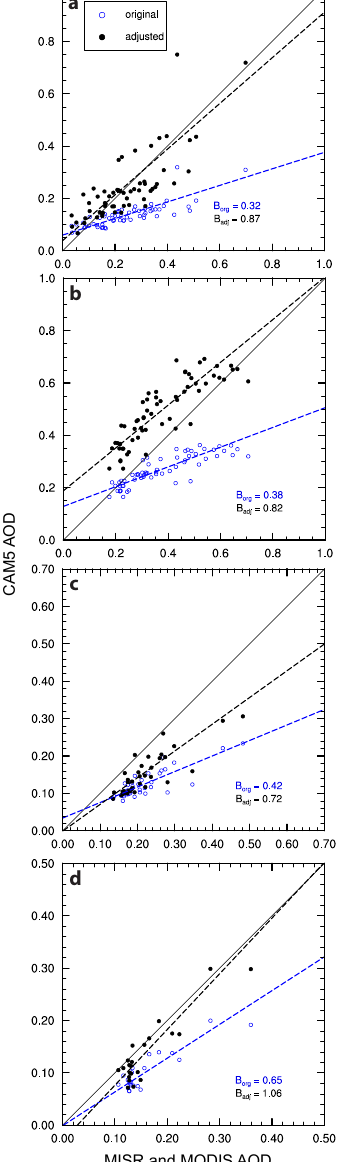
Fig. 2. Linear relations between CAM5-simulated aerosol optical depths (y-axis) and MISR-MODIS optical depths (x-axis) for unad- justed case (blue dots/line) and adjusted case (black dots/line) emis- sions cases. Regression slopes for the original emissions ( B orig. ) and adjusted emissions ( B adj. ) model simulations are shown in each panel. The three regions shown are (a) South America (SAM; 25 ◦ S:0, 40:65 ◦ W), (b) southern Africa (SAF; 15:5 ◦ S,10:30 ◦ E) (c) Equatorial Asia (EAS; 10 ◦ S:7 ◦ N, 90:150 ◦ E), and (d) bo- real North America (BNA; 50 ◦ N:70 ◦ N, 170:90 ◦ W). Only those months that cumulatively contributed 80% of regional emissions from 1997–2009 were included in the analysis. Correlation coeffi- cients ( r 2 ) were 0.65 (unadj.) and 0.62 (adj.) for SAM; 0.72 (un- adj.), 0.55 (adj.) for SAF; 0.69 (unadj.) and 0.71 (adj.) for EAS; and 0.78 (unadj.) and 0.83 (adj.) for